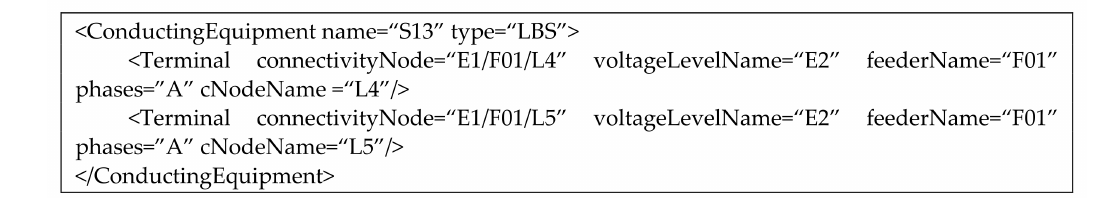
In Figure 1b, S13 is a single-phase switch.